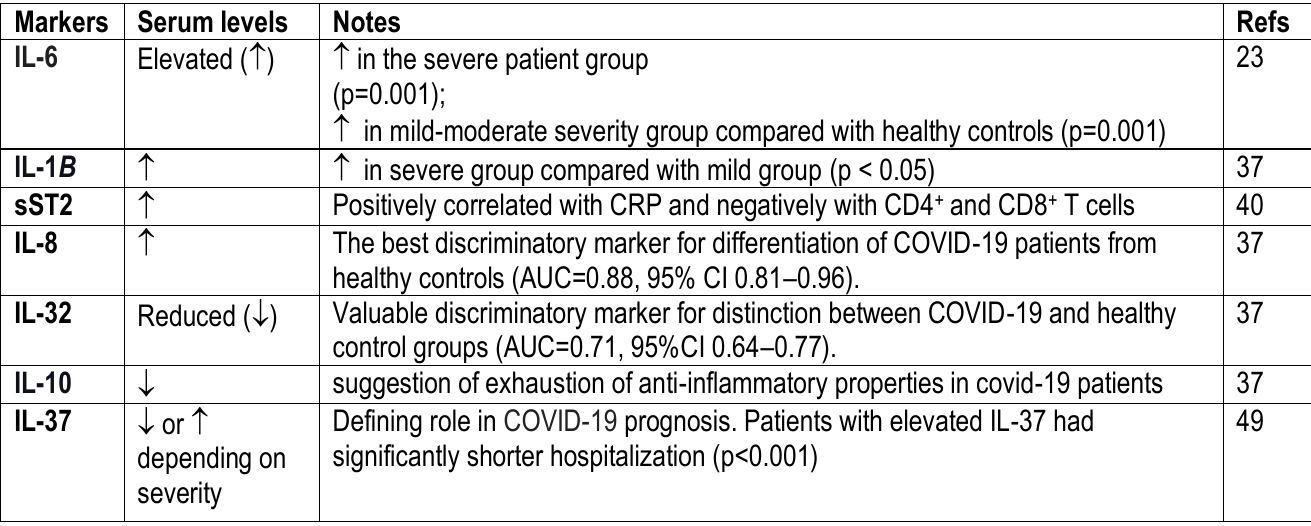
Table 1. Cytokines of COVID-19